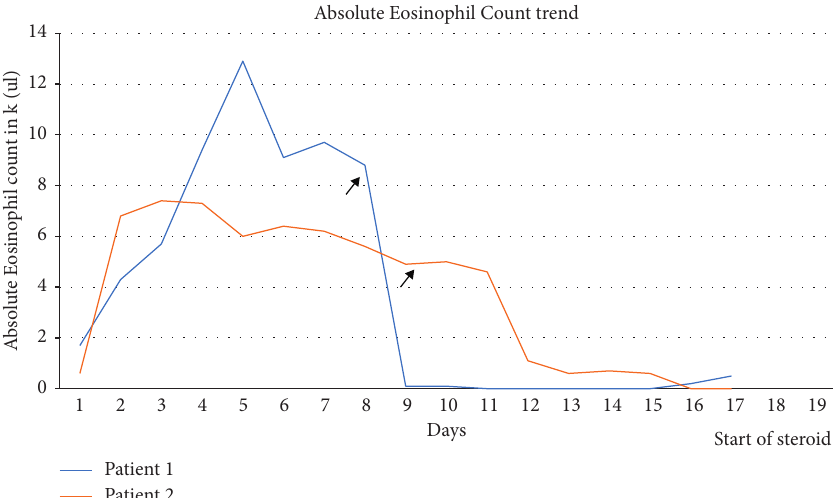
Figure 3: Trend of absolute eosinophil counts (k/ul) of both patients over time following treatment with steroid. Blue line: patient 1; orange line: patient 2. The arrows indicated steroid